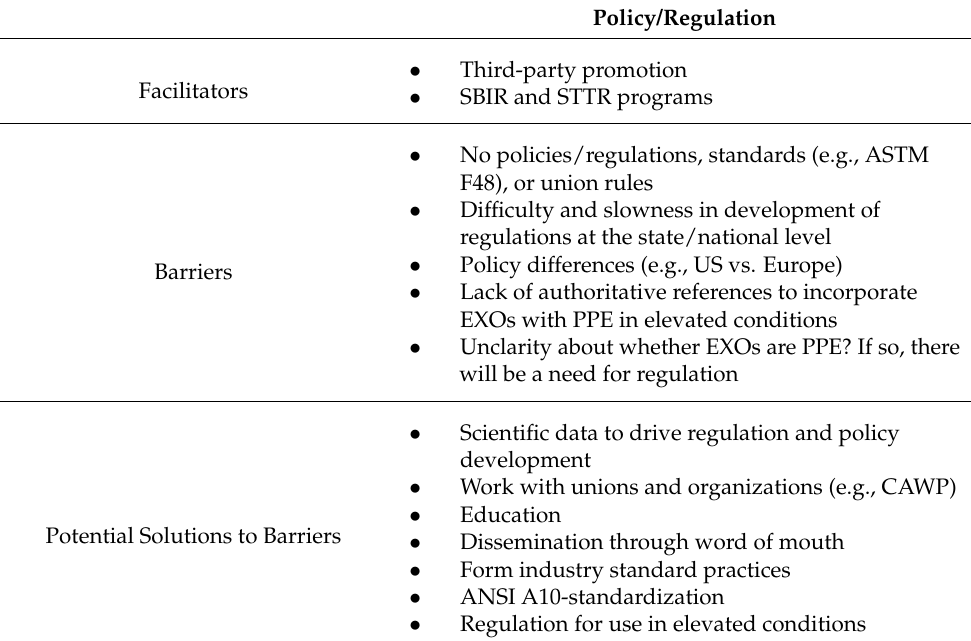
Table 6. Summary of policy/regulation category